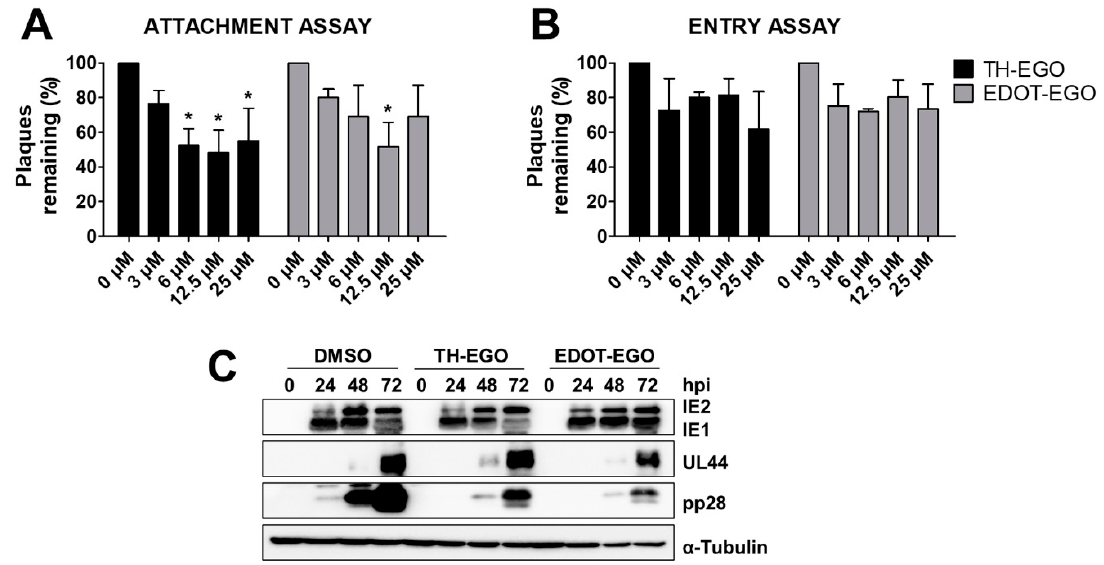
Figure 3. Inhibitory effect on individual stages of viral protein production. ( A ) Attachment assay. HFF cells were infected with HCMV Merlin (MOI of 0.1) in the presence of serial dilutions of either the SLs or vehicle (DMSO); inoculated cultures were then kept for 2 h at 4 ◦ C in presence of SL analogs to allow virus attachment, but not entry, to occur, which were then tested using plaque reduction assays. Plaques were microscopically counted, and the mean plaque counts for each drug concentration were expressed as a percentage of the mean count of the control (*, p < 0.05, two-way ANOVA followed by Bonferroni’s post-tests) ( B ) Entry assay. HFFs were infected in the absence of SLs and kept at 4 ◦ C for 2 h to allow virus attachment to occur; serial dilutions of the compound were added to washed cells and the temperature was then shifted to 37 ◦ C to allow entry to occur. After a single wash with acidic glycine to remove virus particles from the cell surface, cells were overlaid with methylcellulose-containing medium. Data are presented as a percentage of the mean count of the control (two-way ANOVA followed by Bonferroni’s post-tests). ( C ) HFFs were treated with TH-EGO, EDOT-EGO (12.5 µ M) or with equal volumes of DMSO solvent 1 h before infection and for the entire duration of the infection, and infected with HCMV at a MOI of 0.3. Lysates were prepared at the indicated time-points and subjected to Western blot analyses for IEA (IE1 + IE2), UL44, pp28 and α -Tubulin, which was used as a loading